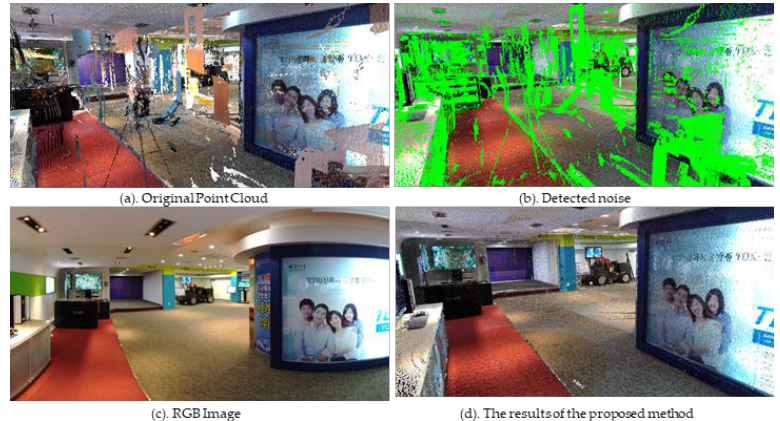
Figure 2. Overview of noise area. Part ( a ) is original point cloud view. The green part in ( b ) is the noise region detected by the method proposed in this paper. ( c ) is the RGB image in the same view. ( d ) is the point cloud after denoising by the method proposed in this paper.